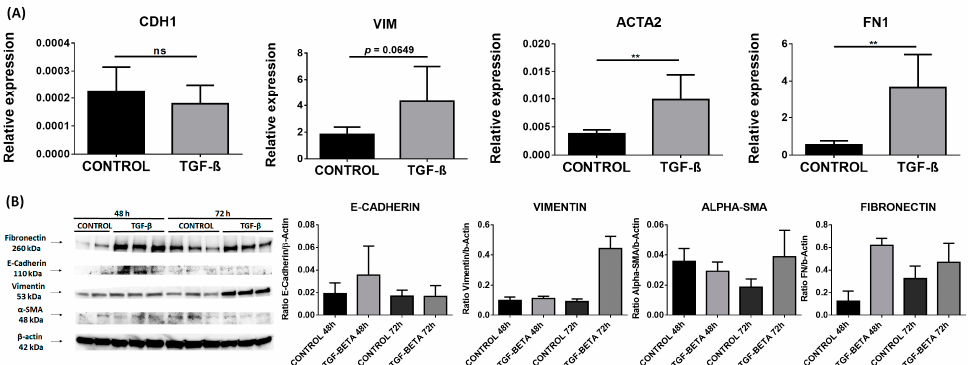
Figure 4. EMT markers in the NThy-ORi 3.1 cell line stimulated with TGF- β . ( A ) RT-qPCR expres- sion of E-cadherin ( CDH1 ), vimentin ( VIM ), fibronectin ( FN ), and α -SMA ( ACTA2 ). Data correspond to the arithmetic mean ± SD. ( B ) Western blot analysis of E-cadherin, vimentin, fibronectin, α -SMA, and Arl13b. Quantitation is indicated below. Abbreviations—ns: not significant. ** p < 0.01.